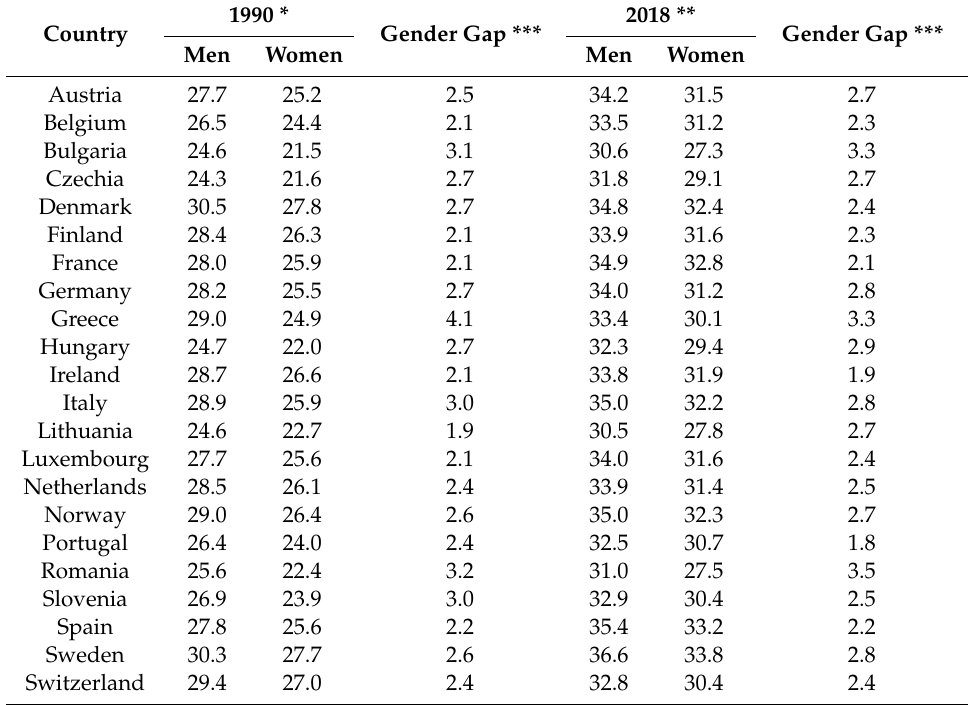
Table 1. Mean age at marriage and absolute gender gap (years) in the mean age at marriage for selected European countries, by year. 1990 * 2018 ** Country Gender Gap *** Gender Gap *** Men Women Men